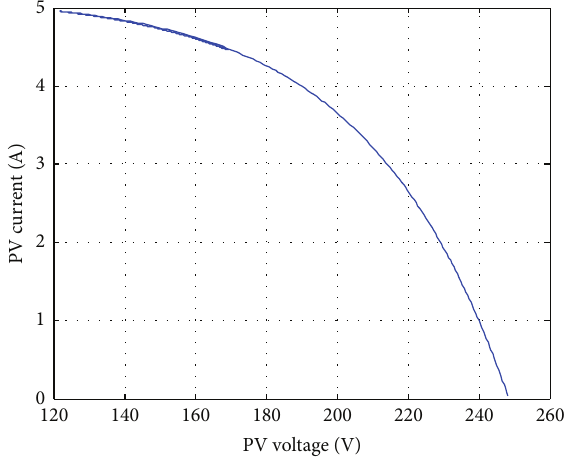
Figure 21: PV current-voltage waveform.